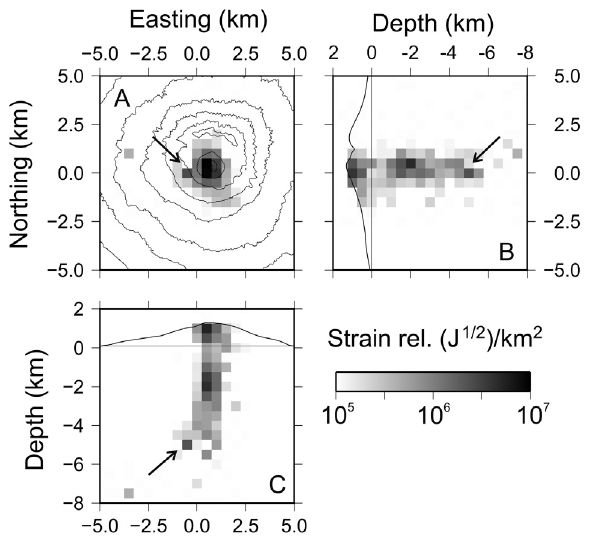
Figure 7. Cumulative strain release. In A we represent the strain re- lease integrated along the vertical direction. In B the integration is performed along the EW direction while in C along the NS direc- tion. The arrows point to a strain release spike related to the Octo- ber 9, 1999, (M=3.6) event. The grids used in the plots are equally spaced with an interval of 500